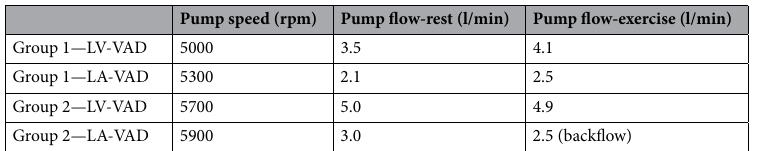
Table 3. Pump settings and resulting flow rates for the two HFpEF groups at rest and